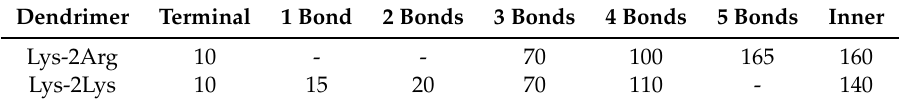
Table 6. The characteristic times [ps] of different CH 2 groups in the side segments of the Lys-2Arg and Lys-2Lys dendrimers at T = 310 K.